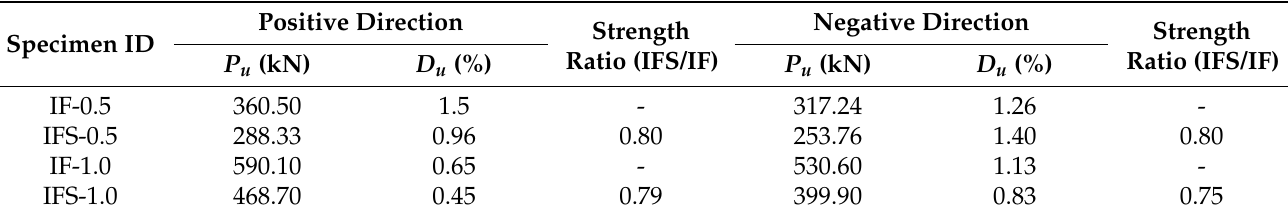
Table 3. Maximum force and corresponding